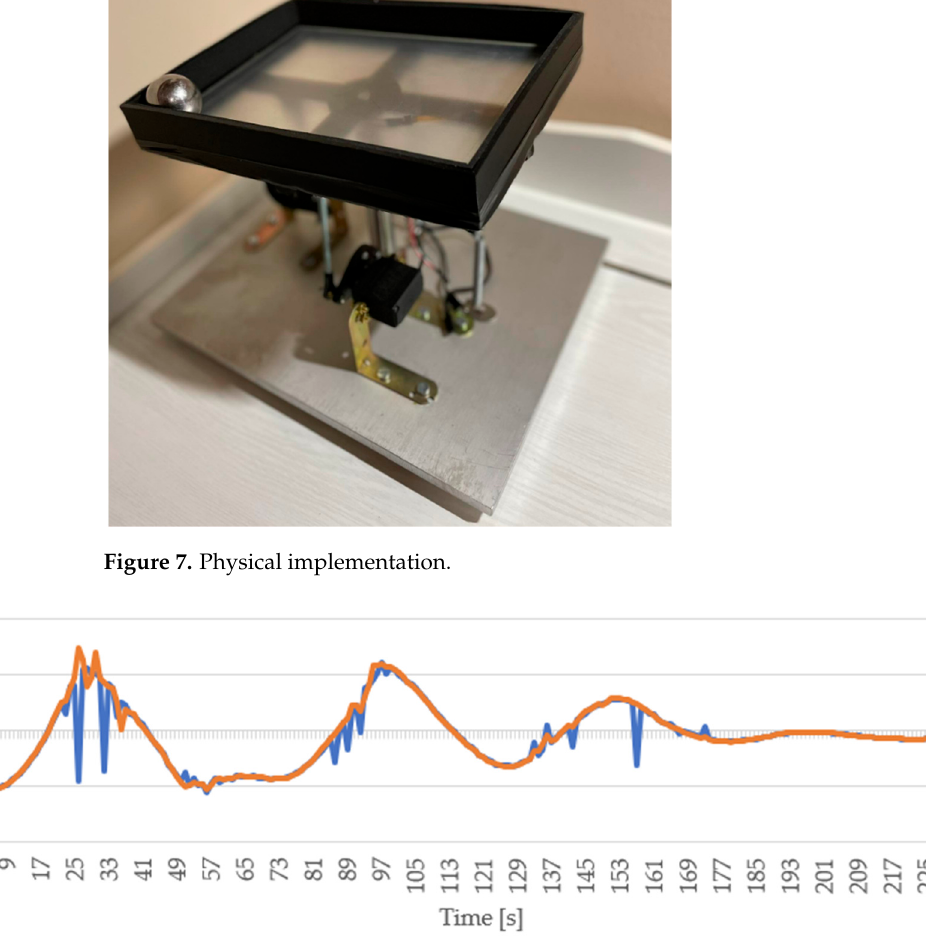
Figure 6. Resistive touch-screen coordinate system.